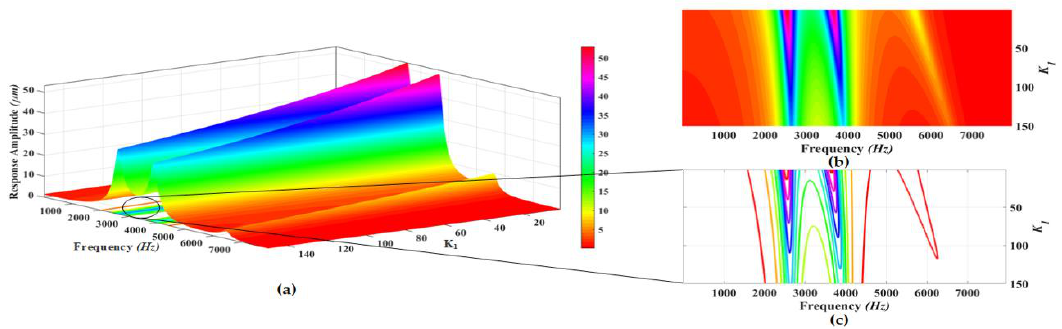
Figure 8. ( a ) Response amplitude and bandwidth optimization graph for the variation of k 1 ; ( b ) Top view and ( c ) Contour plots of the system response.